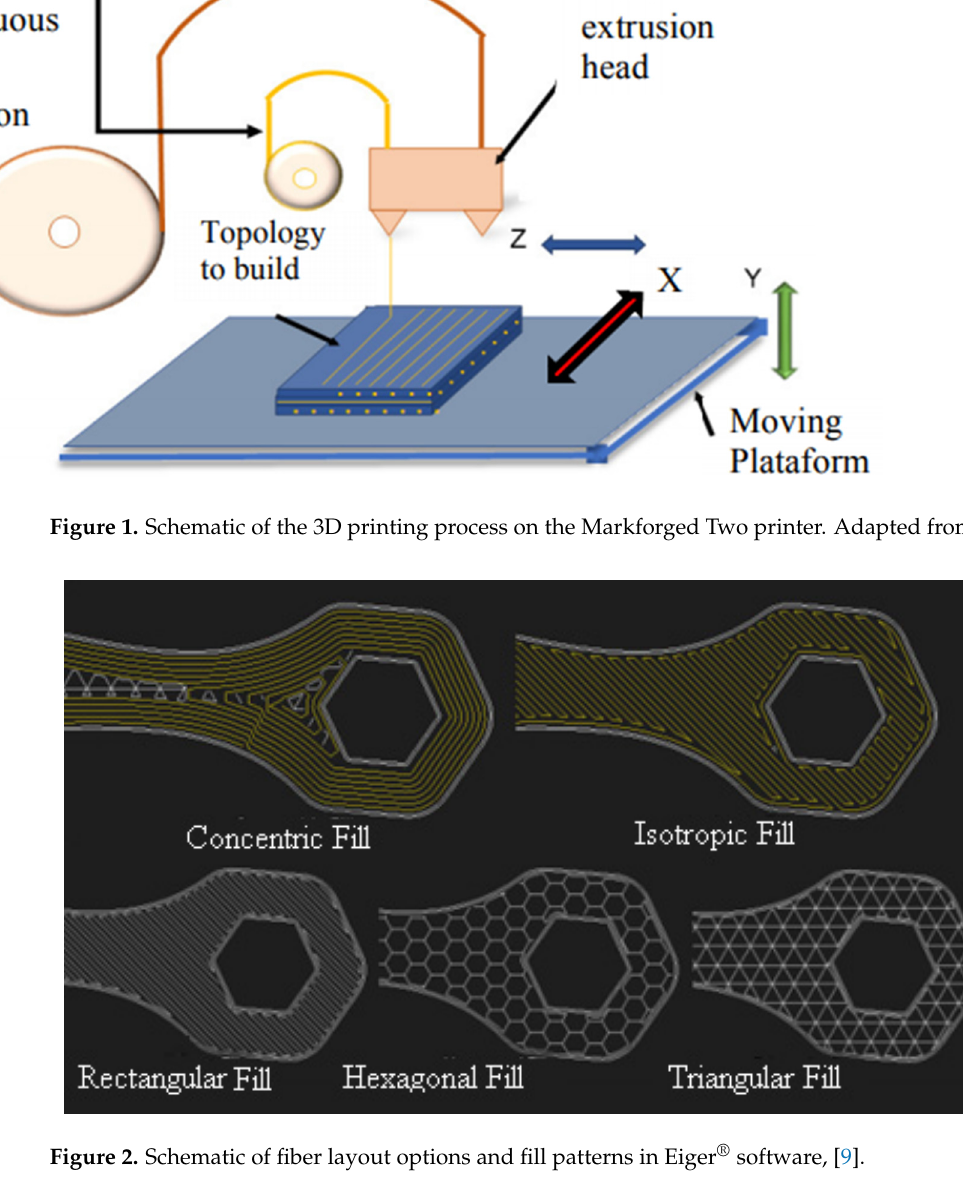
Figure 2. Schematic of fiber layout options and fill patterns in Eiger ® software, [9]. Table 1. Individual mechanical properties as reported by Markforged